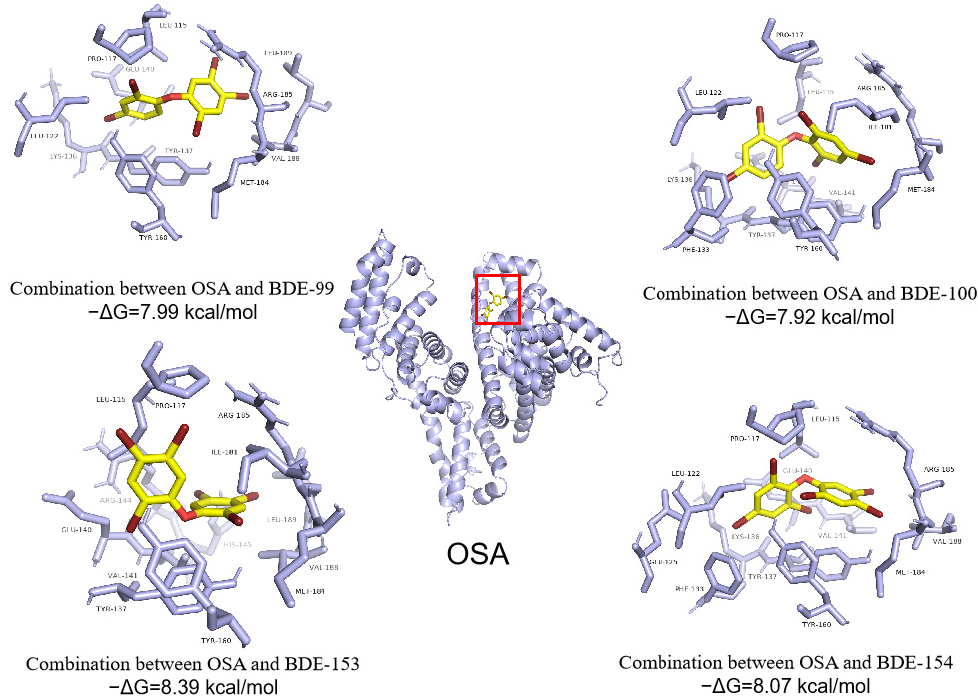
Figure 6. Molecular docking images for interactions between PBDE congeners and ovine serum albumin (OSA) at 298.15 K and the amino acid residues in OSA that interact with the PBDE congeners over the range 4 Å.